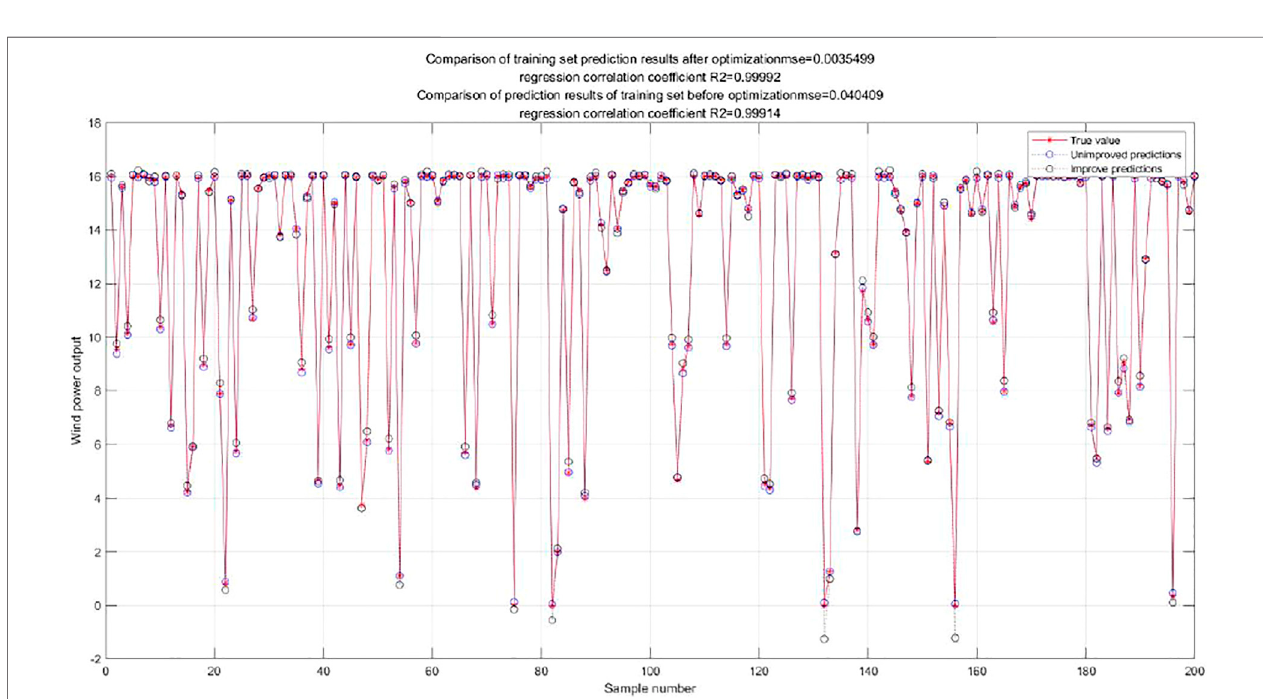
FIGURE 7 | Comparison of CSO optimized BP neural network